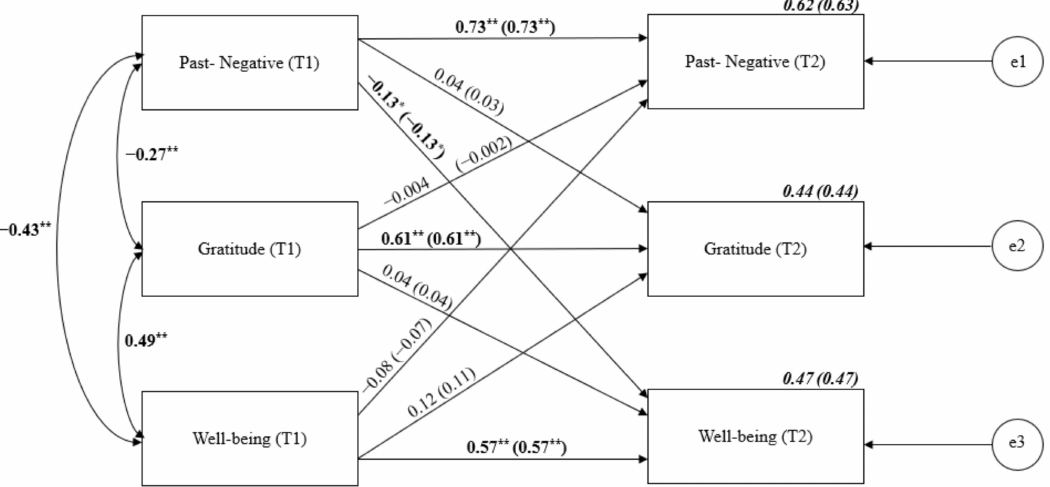
Figure 2. Cross-lagged panel analysis of Past-Negative TP, gratitude and well-being. Notes: Path entries are standardized estimates. T1 and T2 indicate the time when data were collected (Time 1 or Time 2, respectively). Estimates for the corresponding model with age and gender controlled are given in brackets. e1–e3 refers to the residual error or error variance that causes response variation in observed variables. * p < 0.05; ** p <